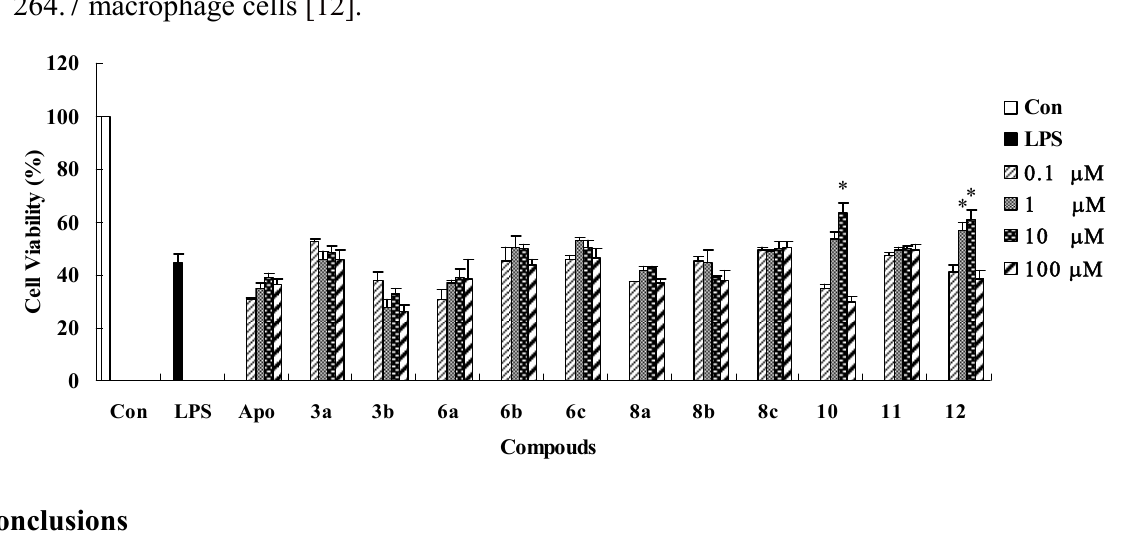
Figure 4. Protective effects against LPS (lipopolysaccharide)-induced cytotoxicity in RAW 264.7 macrophage cells